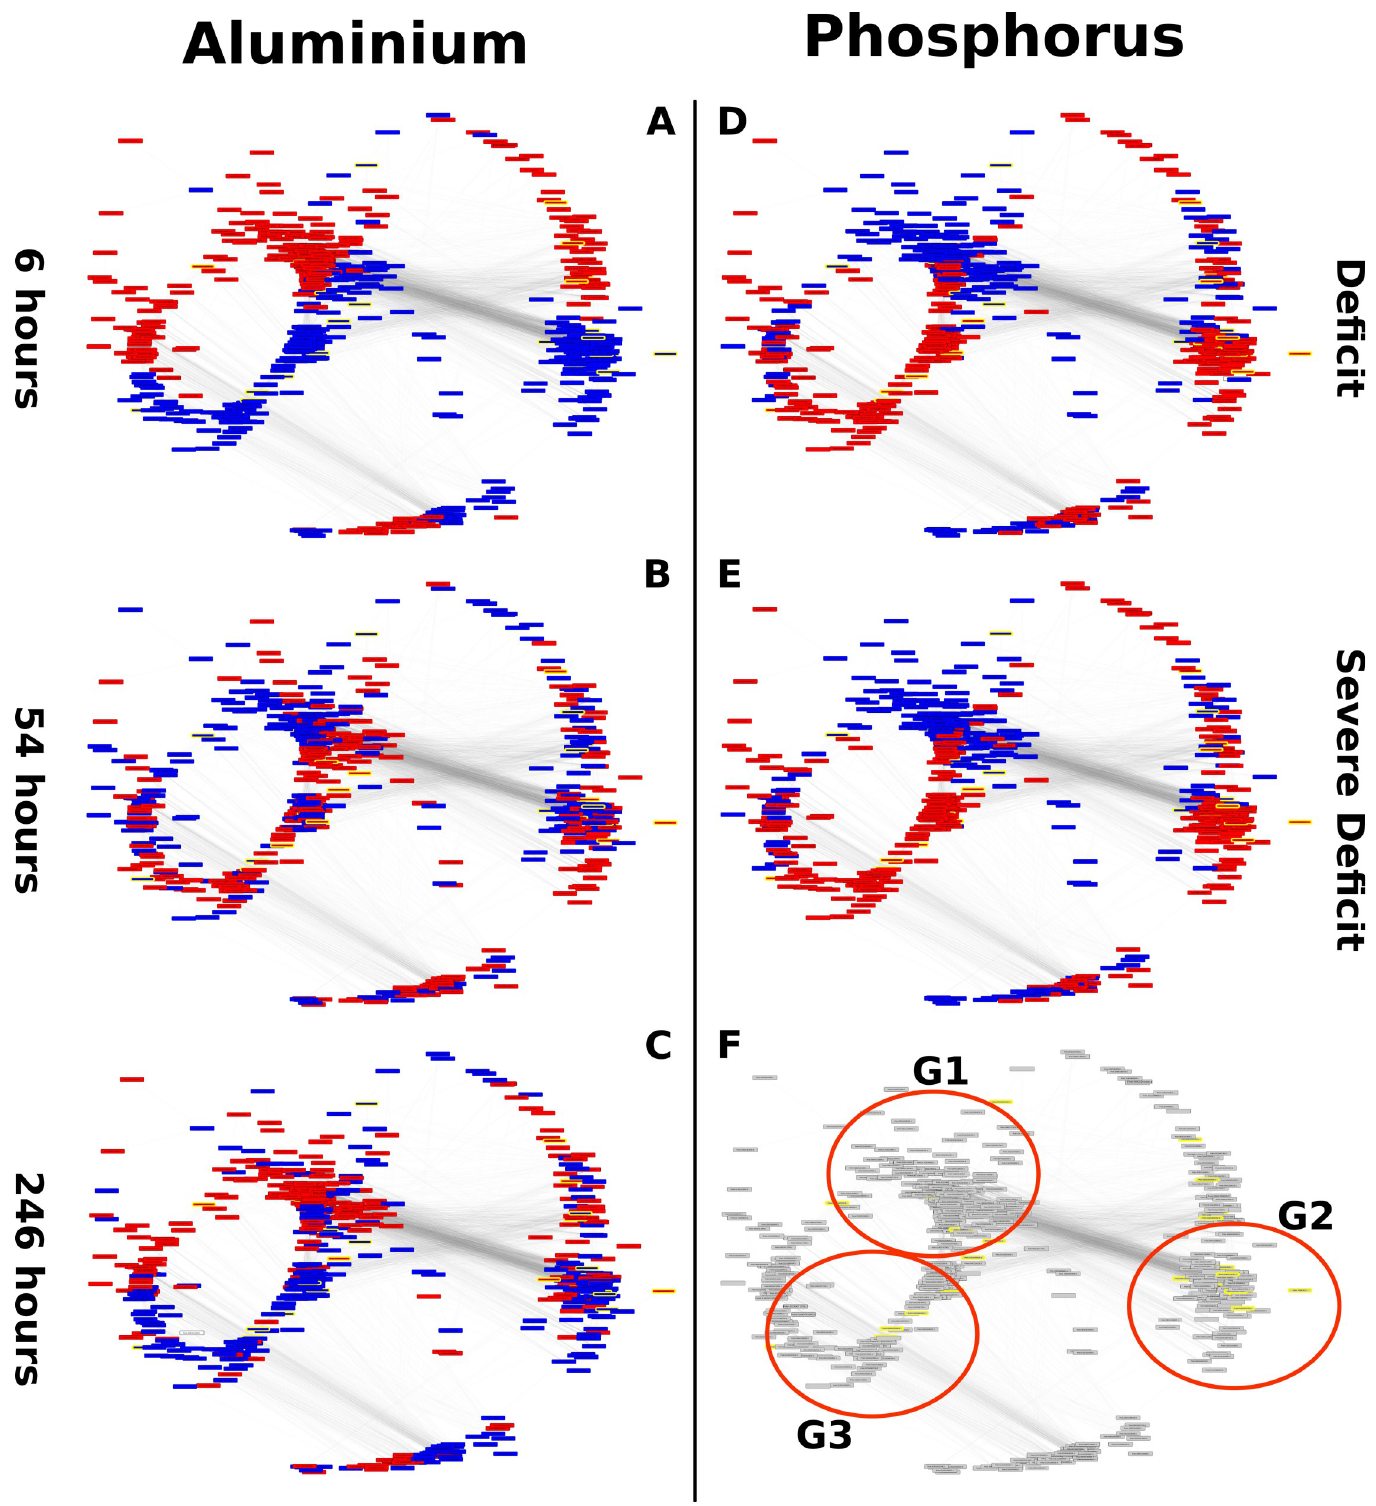
Fig 5. Co-expression networks between genes regulated by phosphate deficiency and aluminium toxicity. The green colour represents genes regulated positively (stress/normal condition > 1) and the red colours genes regulated negatively (stress/normal condition < 1). A- Regulation by aluminium stress at 6 h; B- Regulation by aluminium stress at 54 h; C- Regulation by aluminium stress at 246 h; D- Regulation by normal phosphate deficiency; E- Regulation by severe phosphate deficiency; F- groups of genes with different regulation between the two stresses, G1, G2 and G3. https://doi.org/10.1371/journal.pone.0223217.g005 PLOS ONE | https://doi.org/10.1371/journal.pone.0223217 October 10,